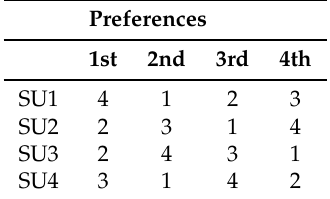
Table 4. SUs preference list.